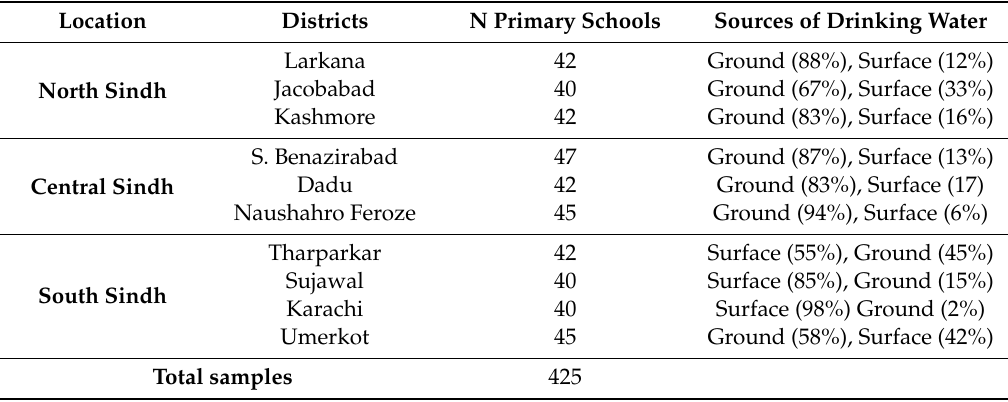
Table 1. Details about the sampled districts, schools, and sources of the water samples.